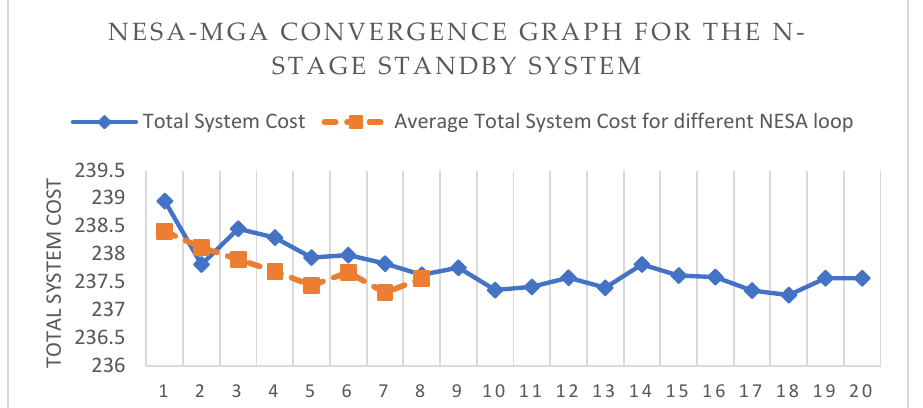
Figure 6. The convergence graph of the n -stage standby system by conducting the NESA-MGA combined method.